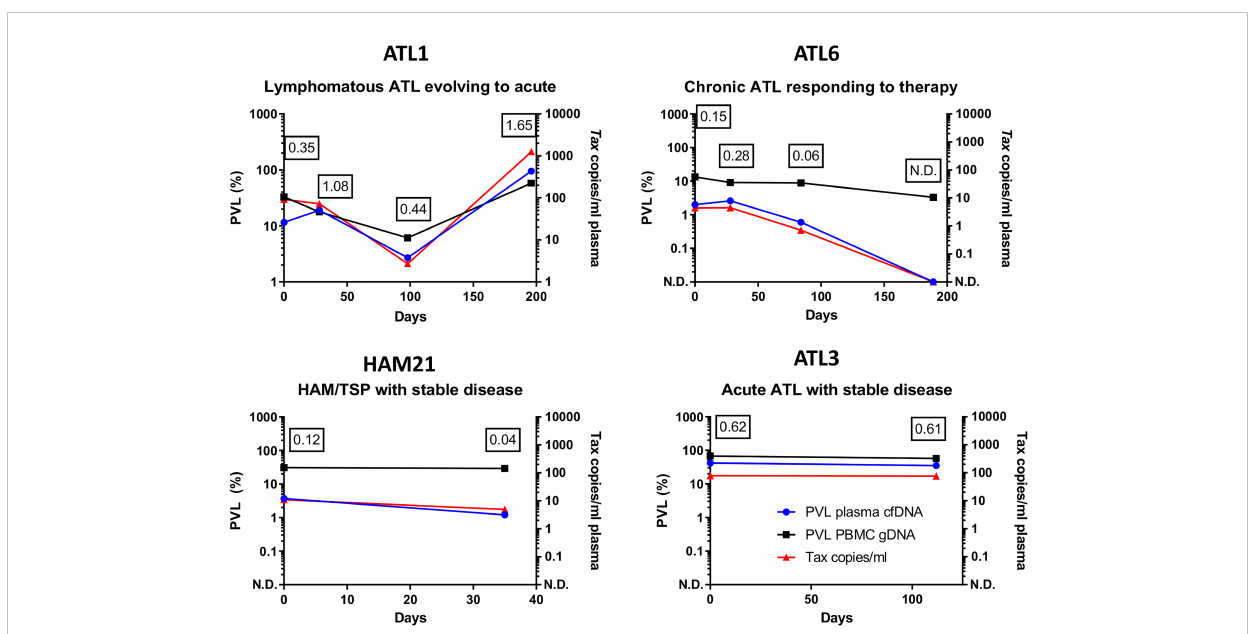
FIGURE 3 Longitudinal monitoring of HTLV-1 proviruses in cfDNA. qPCR was used to quantify the copy number of Tax and HBB in plasma cfDNA and PBMC gDNA in blood donated by four patients. Results were plotted as copies of Tax/ml and the percentage of cells carrying HTLV-1 proviruses (PVL) in PBMC gDNA and plasma cfDNA. Patient ATL1 had lymphomatous ATL which evolved to acute ATL on day 200. Patient ATL6 had chronic ATL was treated with Zidovudine/Interferon alpha (day 0-day 189 inclusive) and responded to therapy. Patients HAM21 (HAM) and ATL3 (Acute ATL) had stable disease. The ratio of the PVL of cfDNA to the PVL of PBMC gDNA is shown at each timepoint tested to illustrate differences between patients. N.D. indicates HTLV-1 Tax was not detected. Figures in boxes indicate the ratio of the plasma cfDNA PVL to the PBMC gDNA PVL at each timepoint